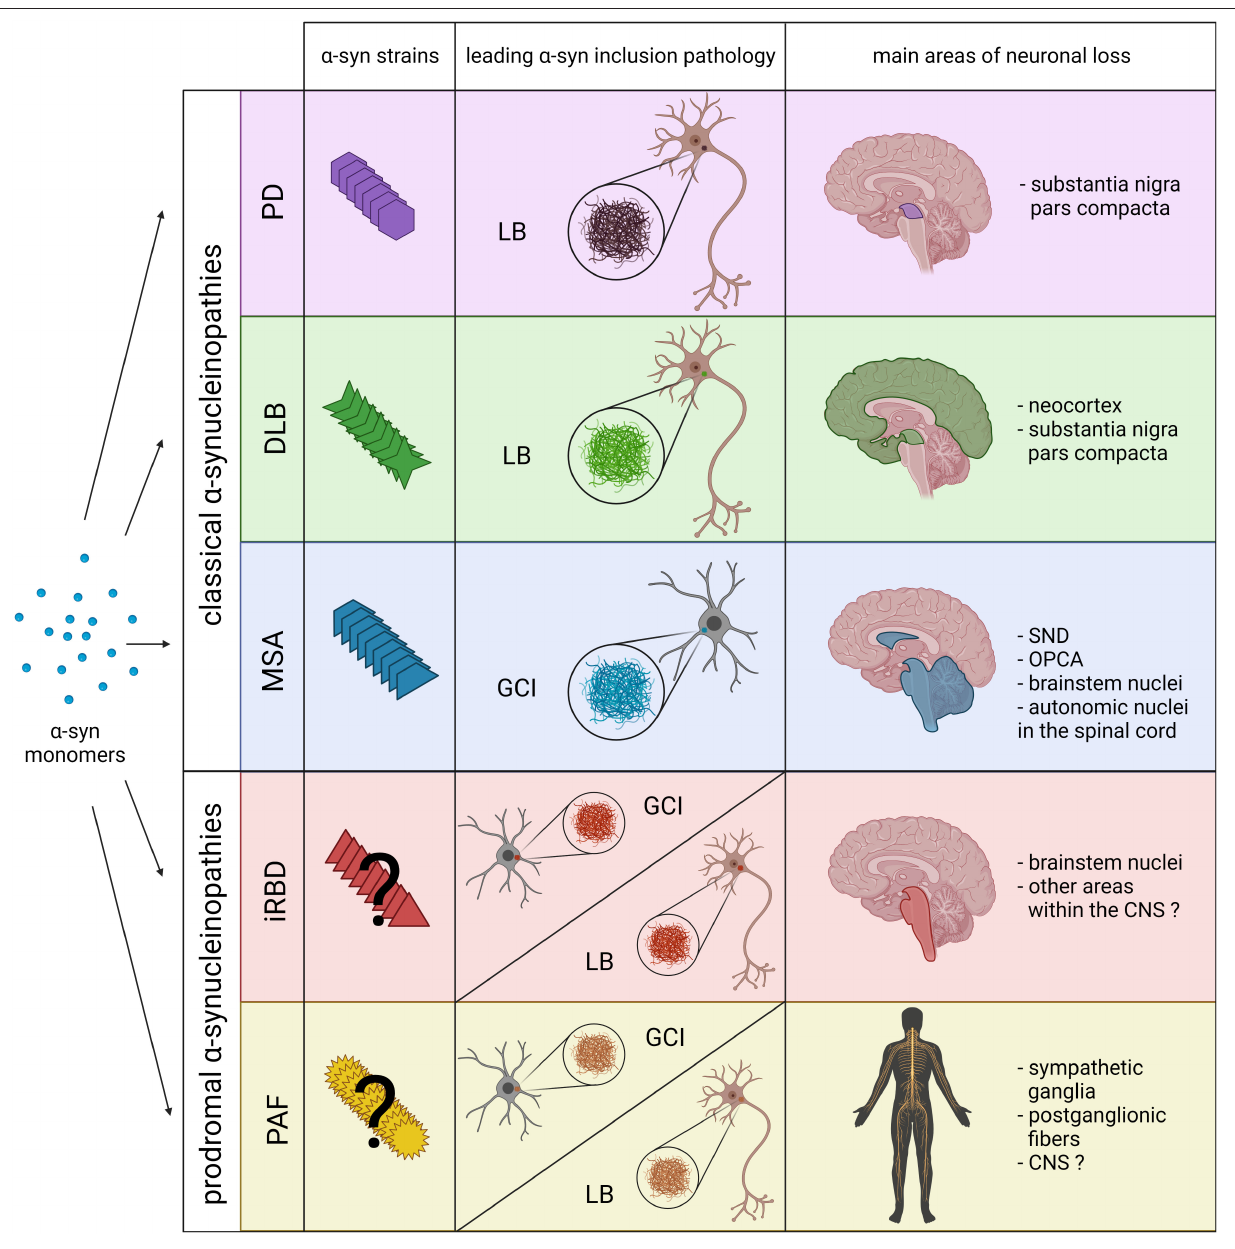
FIGURE 1 | Schematic overview including the main pathological features of prodromal and classical α -synucleinopathies. The combination of novel structural and biochemical analyses have demonstrated the existence of different α -syn strains in classical α -synucleinopathies (PD, DLB and MSA). Recent experimental data also indicate that distinct α -syn strains might be associated, not only with the affected cell type and type of α -syn inclusion (neuronal LBs vs. oligodendroglial GCIs), but also with the neurodegeneration pattern and disease severity. However, at present it is still unclear whether distinct α -syn strains are also associated with prodromal α -synucleinopathies, or if they only constitute early phases of classical α -synucleinopathies. Thus, pathological α -syn in PAF and iRBD patients could lead to the formation of LBs, GCIs and the extension of neuronal loss to other areas within the CNS. SND, striatonigral degeneration; OPCA, olivopontocerebellar atrophy. Created with